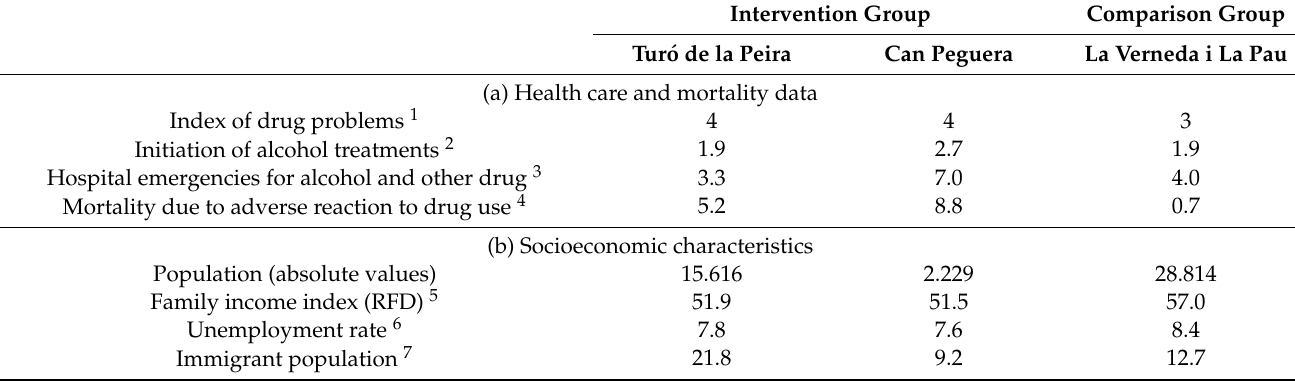
Table A1. Characteristics of the intervention and comparison neighborhoods. Intervention Group Comparison Group Tur ó de la